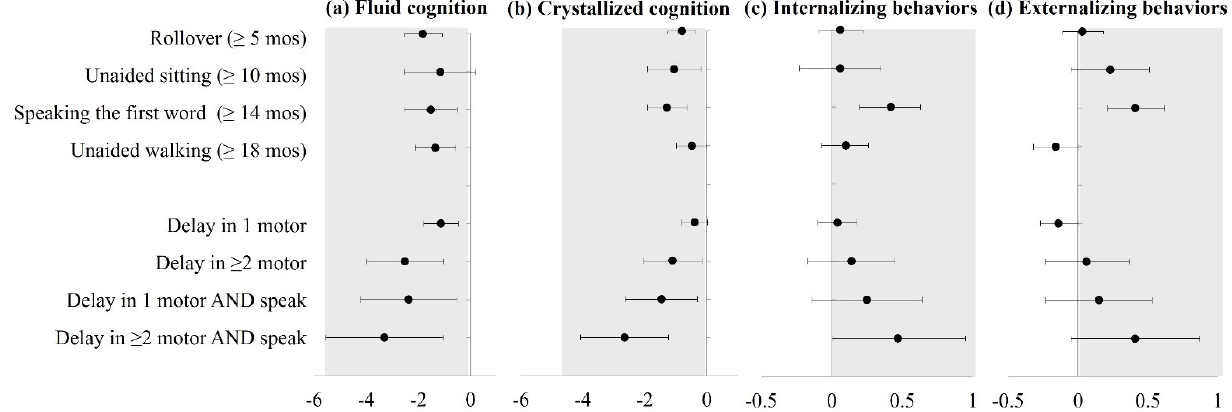
Figure 1. Estimated mean score differences (and 95% CI) of delays in individual milestone attainment (top panel) and multiple milestone attainment (bottom panel) with childhood neurodevelopment at ages 9–10, including: ( a ) fluid cognition; ( b ) crystallized cognition; ( c ) internalizing behaviors; ( d ) externalizing behaviors, adjusted for maternal sociodemographic characteristics (age at delivery, race/ethnicity, marriage status, education level, residential average of family income, self-reported mental health problems) and child’s sex at birth. Note: Gray area indicates poorer neurodevelopmental outcomes, with lower scores of cognition tests and higher scores of behavioral tests indicating more problems. In total, 3.1% children had delays in ≥2 motor milestones, and 1.3% children had delays in ≥2 motor and language milestone .